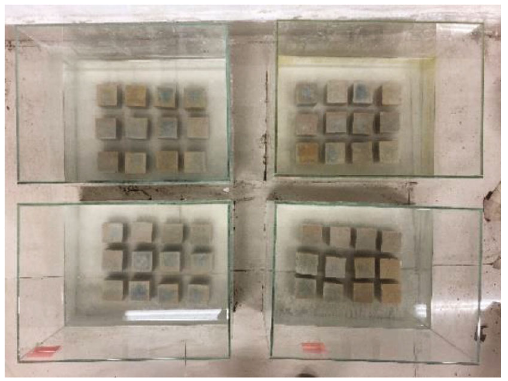
Figure 2: Sample